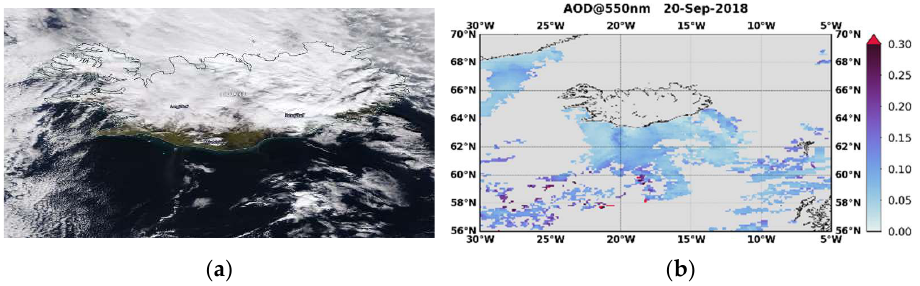
Figure 13. The evidence of the dust storm event in Iceland on 20 September 2018. Detected dust plumes reached Faroe Islands next day: ( a ) MODIS true color; and ( b ) MODIS AOD.